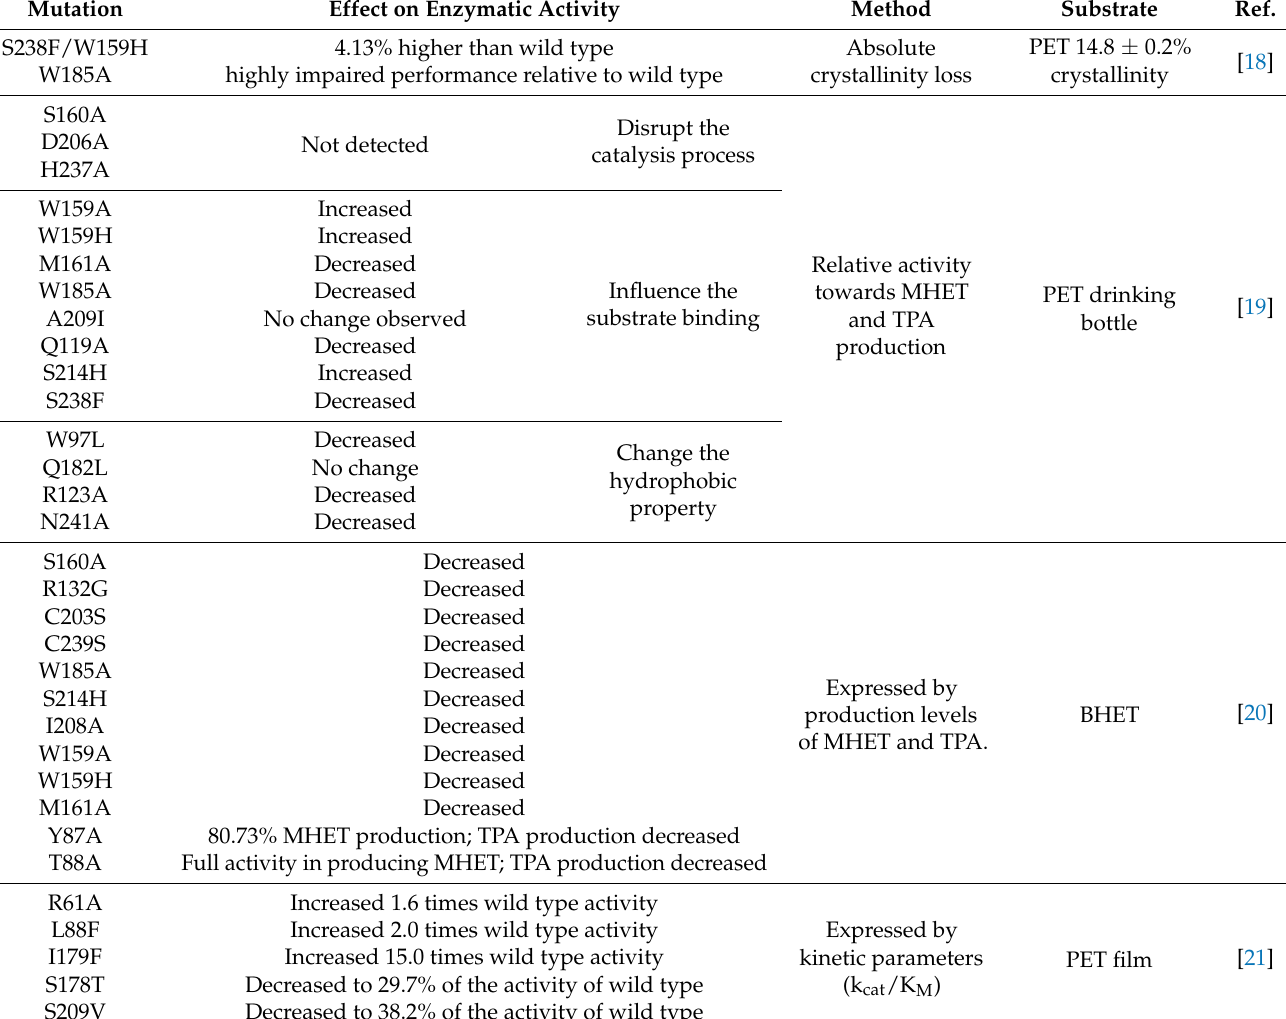
Table 1. Mutations of Is PETase structure for modifying its PET-degrading activity.